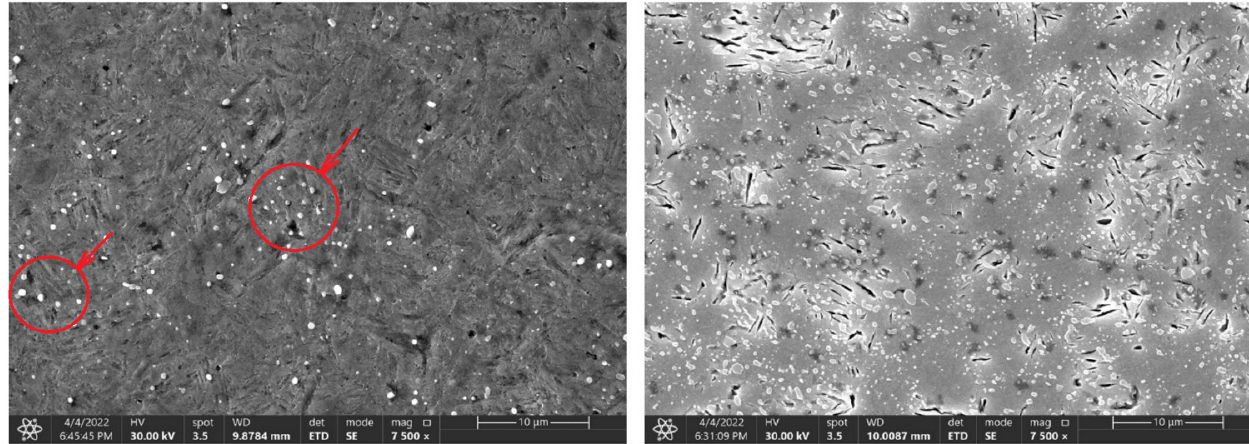
Figure 10. Change in the microstructure of the 80CrV5 steel, with a heating time of 140 s and 3600 s. Areas with chromium carbides are marked in the figure.